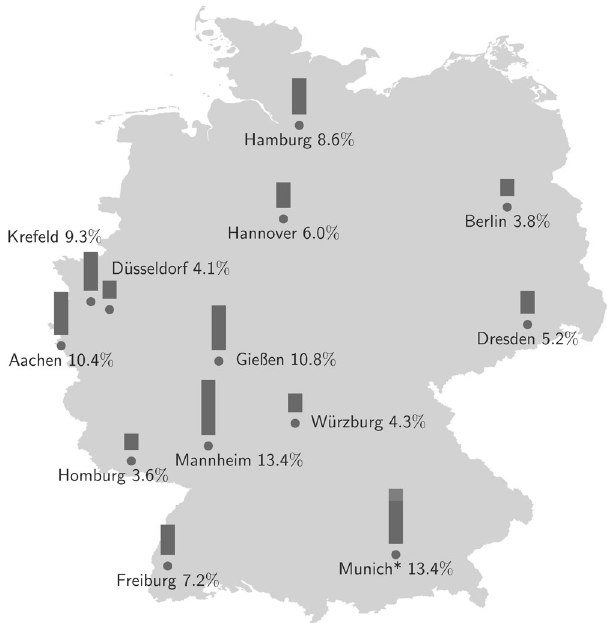
Fig. 1 Distribution of study centres. 14 children ’ s hospitals, spread all over Germany, took part in the SARS-CoV-2 study. In total 10,358 pedaitric patients participated. The proportion of recruitment per study centre